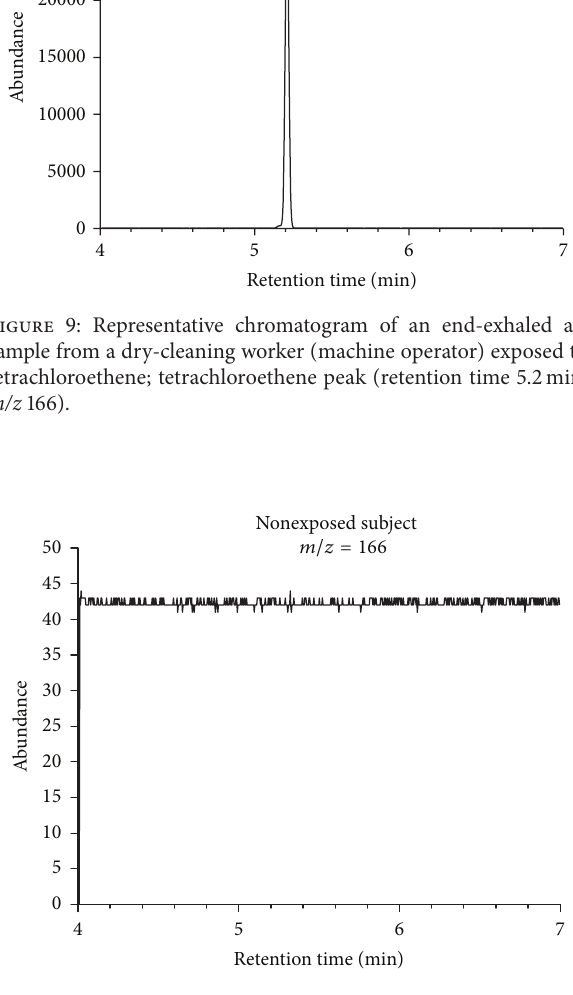
Figure 10: Representative chromatogram of an end-exhaled air sample from a nonexposed subject (control